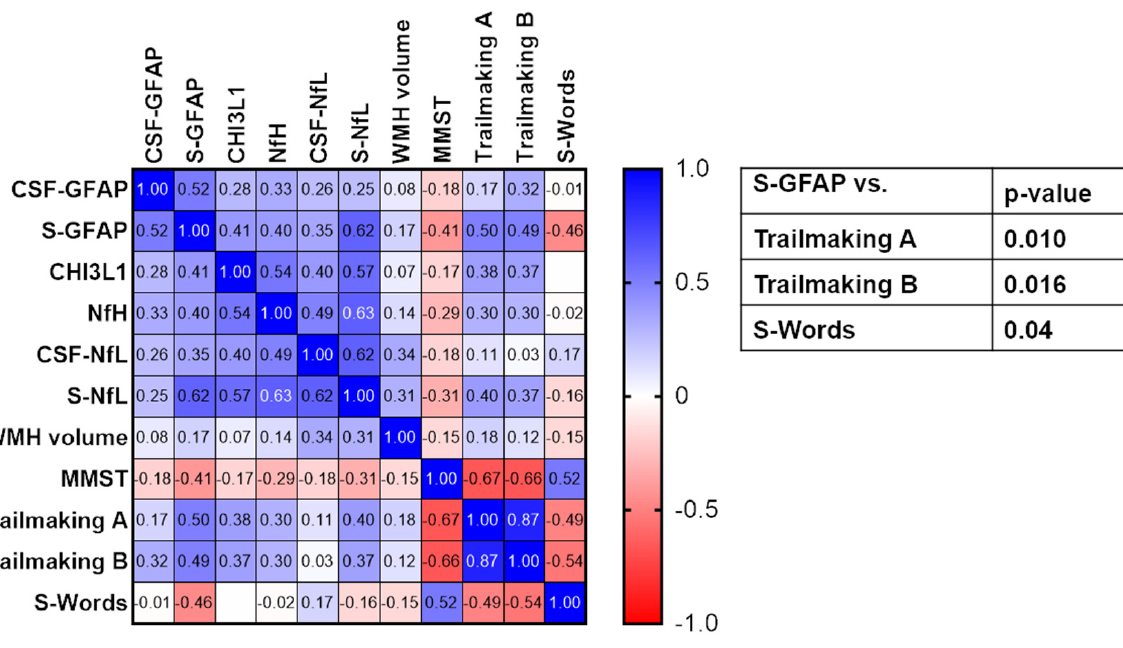
Figure 5. Correlation matrix of CSF and serum (S) biomarkers and neurocognitive parameters (MMST, Trail Making A and B and S-Words). Numbers in the heat map give the Spearman’s correlation coefficient. p -values in the table only show significant correlations after correction for multiple testing with Bonferroni’s correction.